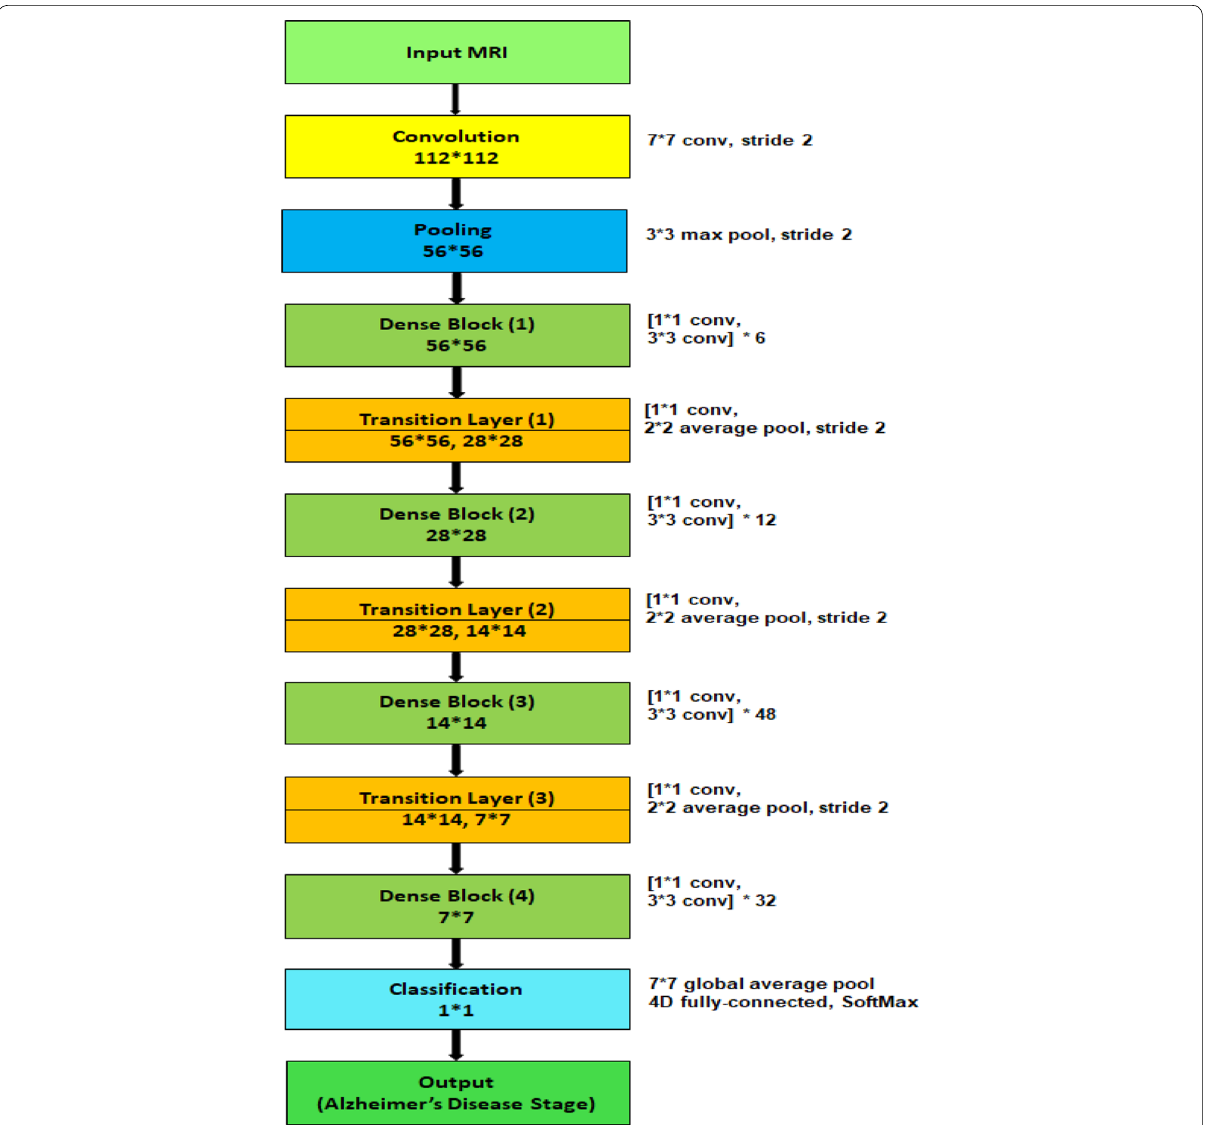
Fig. 6 Block diagram of individual model M